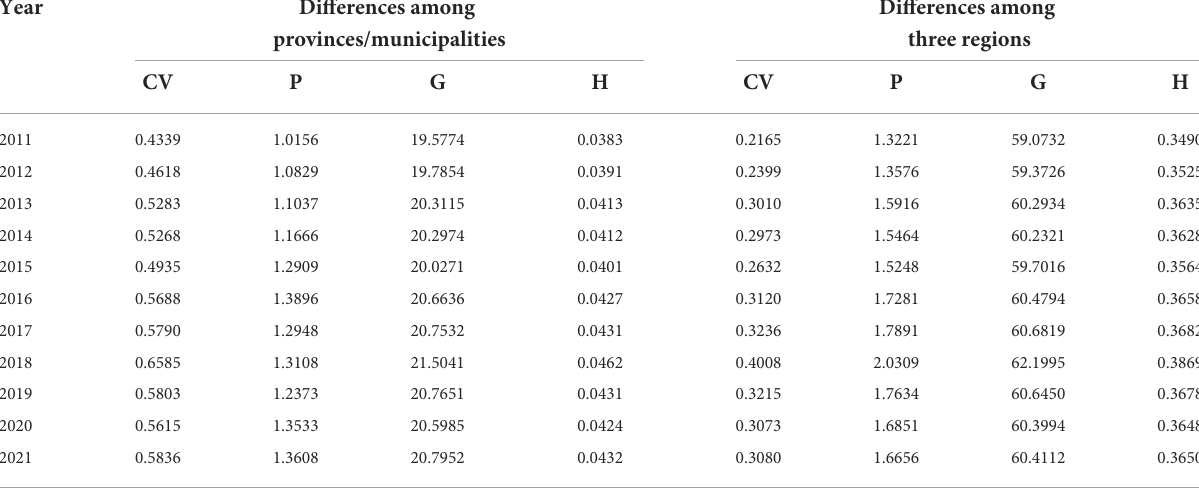
TABLE 3 Differences in OAV among provinces/municipalities and among the three regions in China from 2011 to 2021. Year Differences